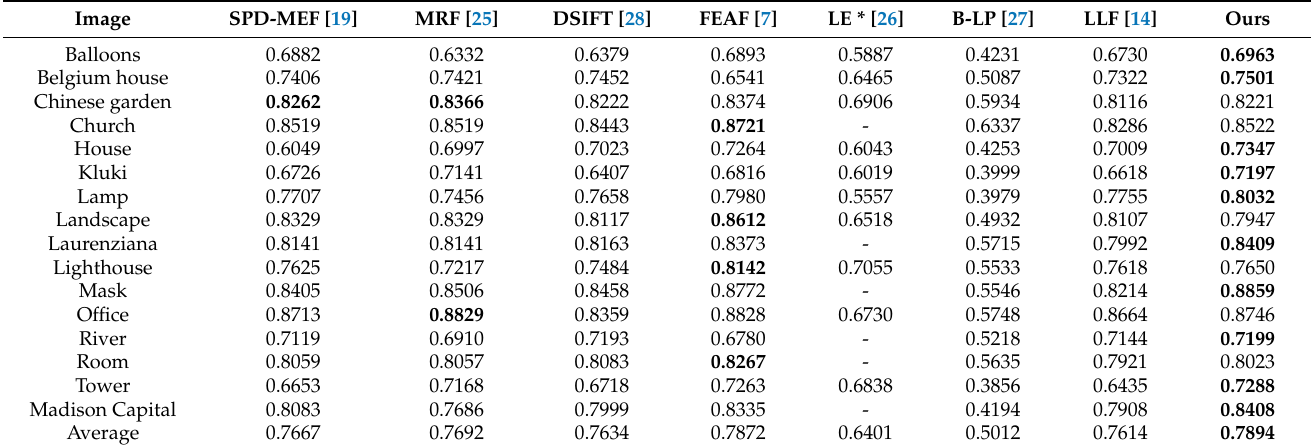
Table 3. Comparison of image quality assessment ( Q AB / F ) with existing MEF techniques.